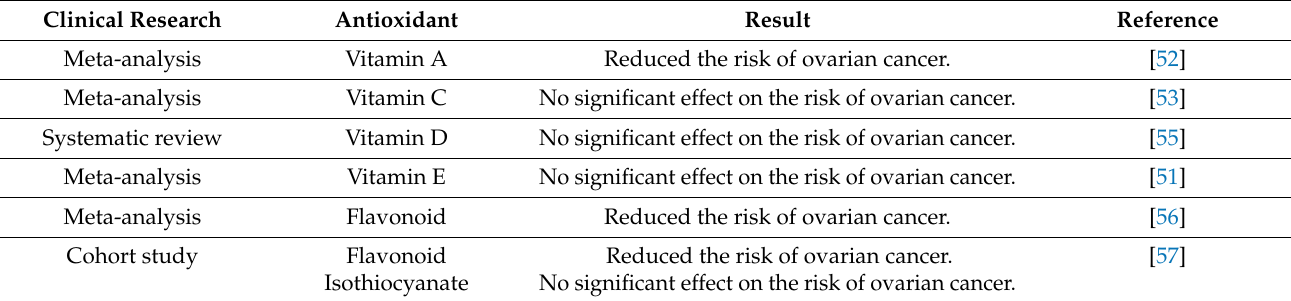
Table 1. Antioxidant supplements and foods against ovarian